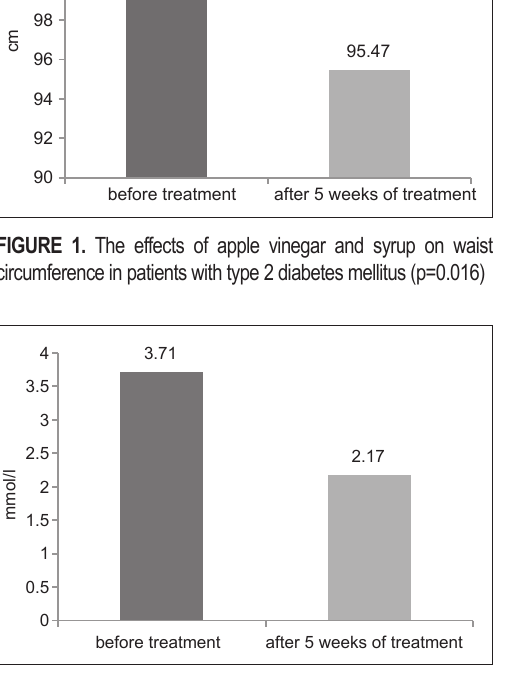
FIGURE 2. The effects of apple vinegar and syrup on triglycerides in patients with type 2 diabetes mellitus (p=0.019)